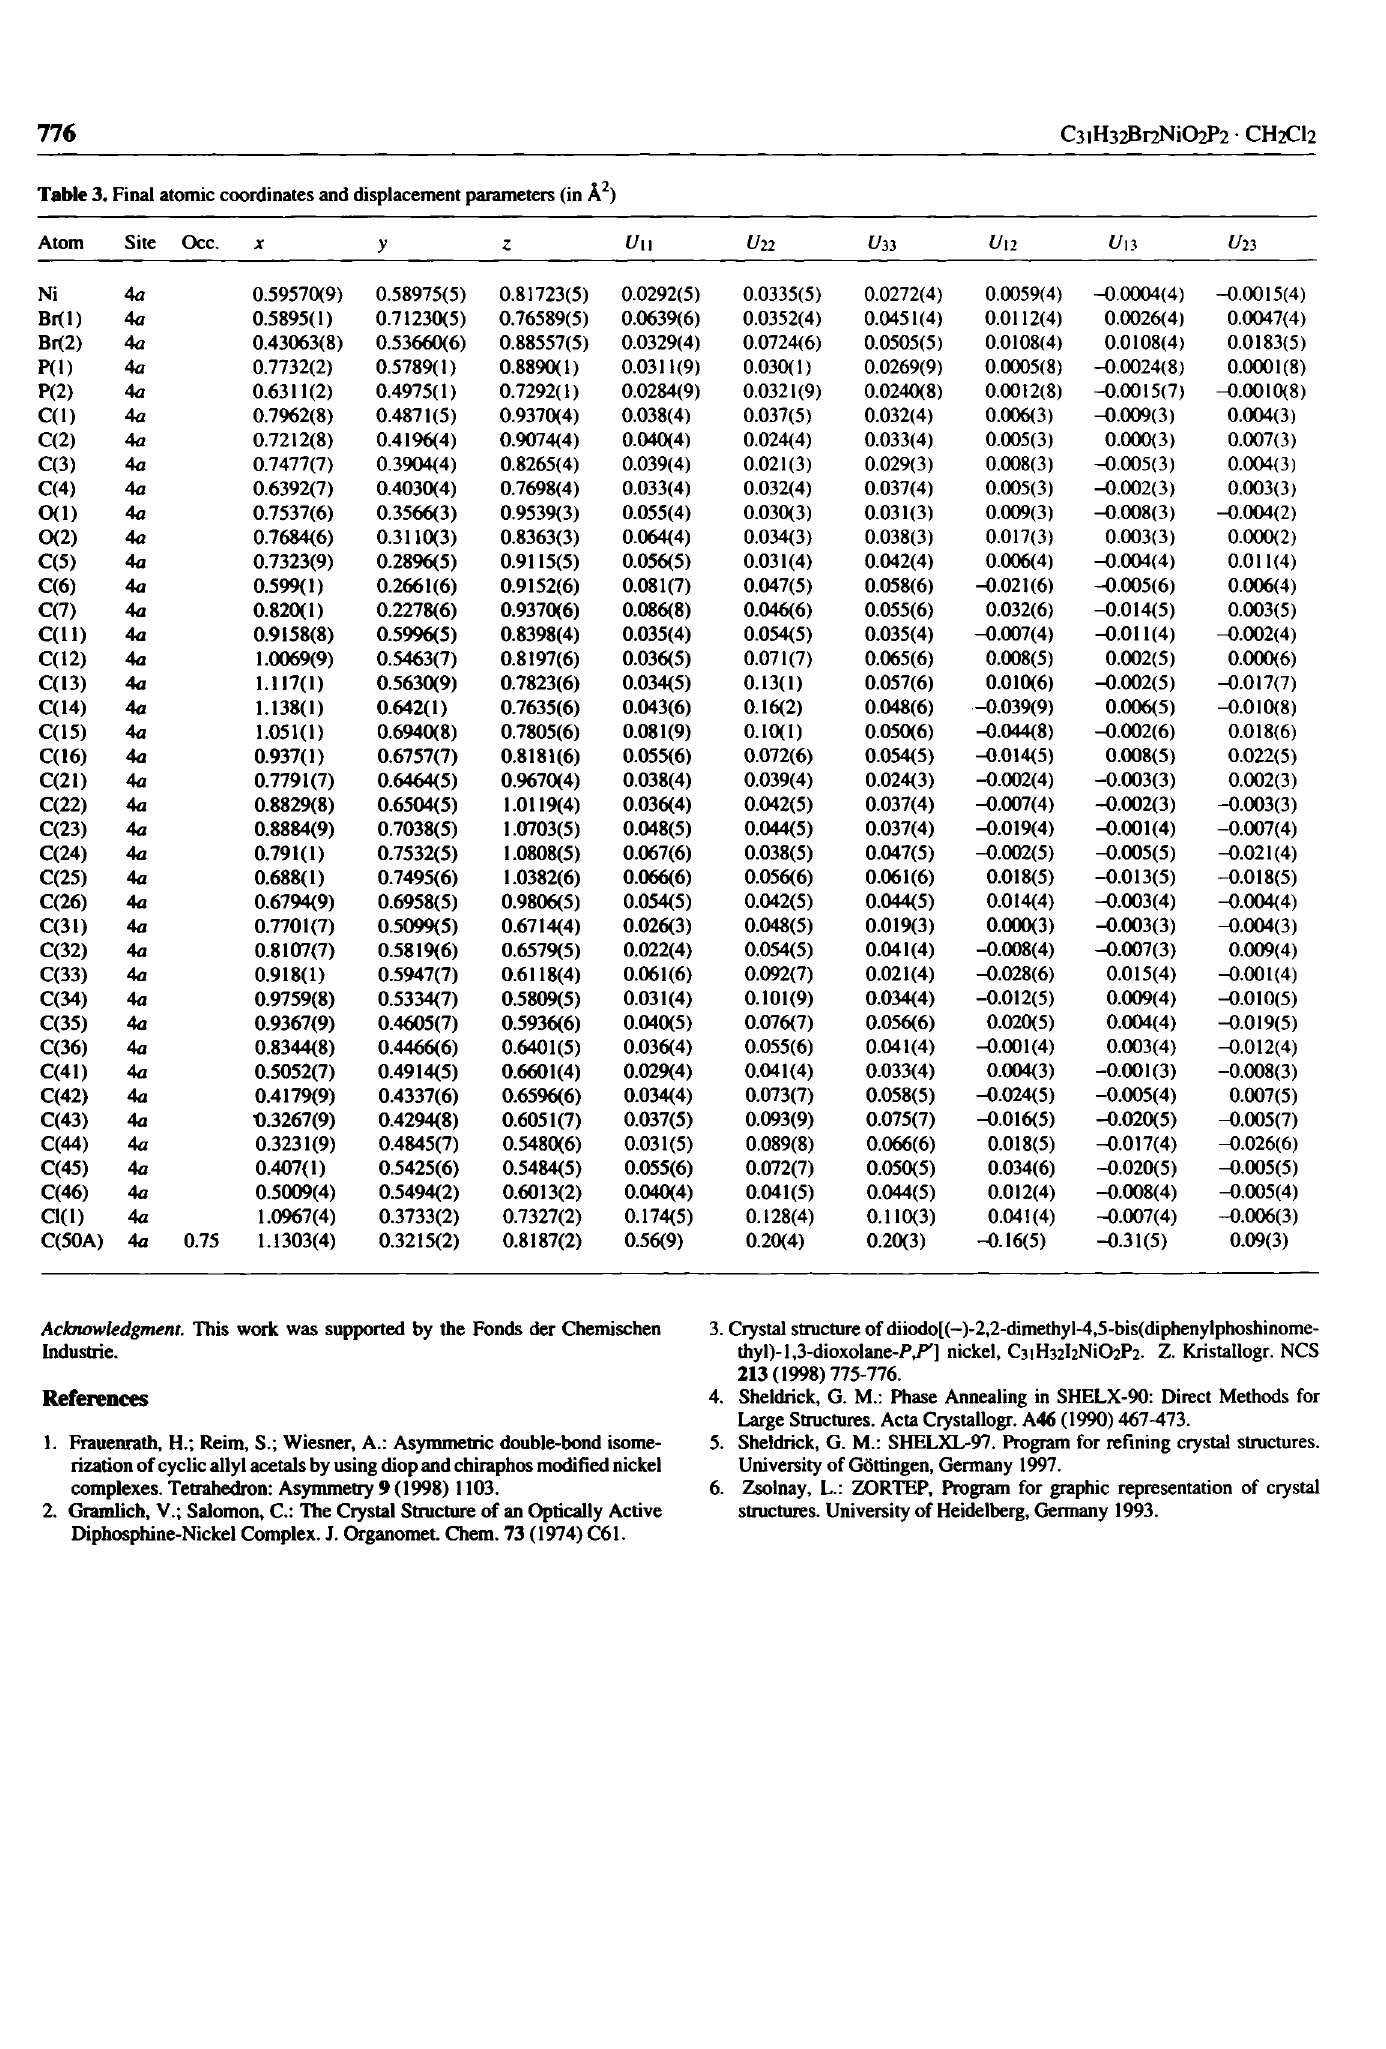
Table 3. Final atomic coordinates and displacement parameters (in